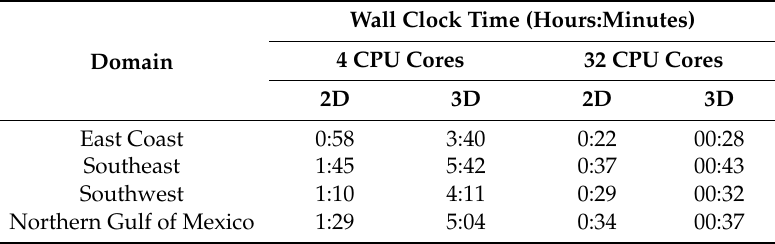
Table 3. Average wall-clock time for ACMS simulations (a simulation consists of a 6-h hindcast/nowcast and a 72-h forecast) per domain. Times can vary from cycle to cycle, depending on conditions and number of wetted grid